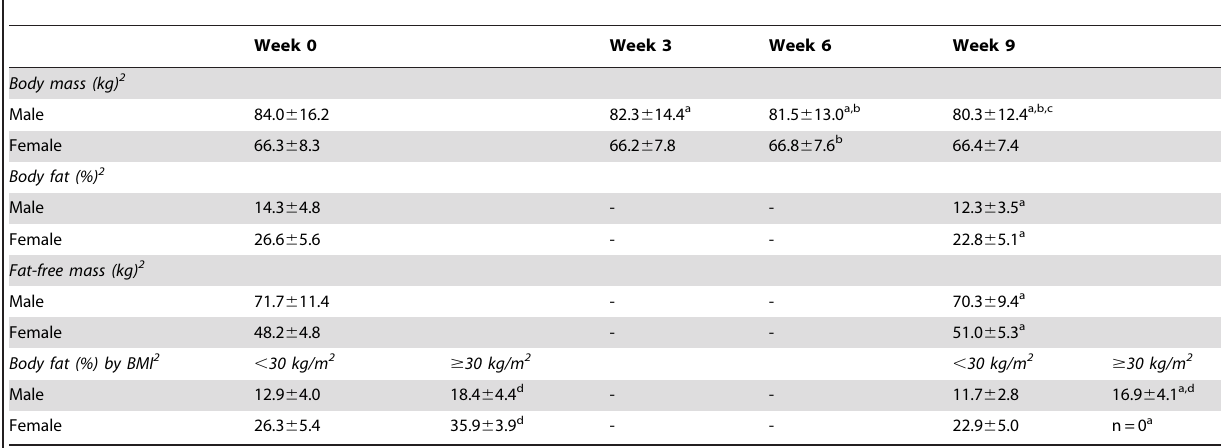
Table 2. Body mass and body composition of US Army recruits during basic combat training. 1